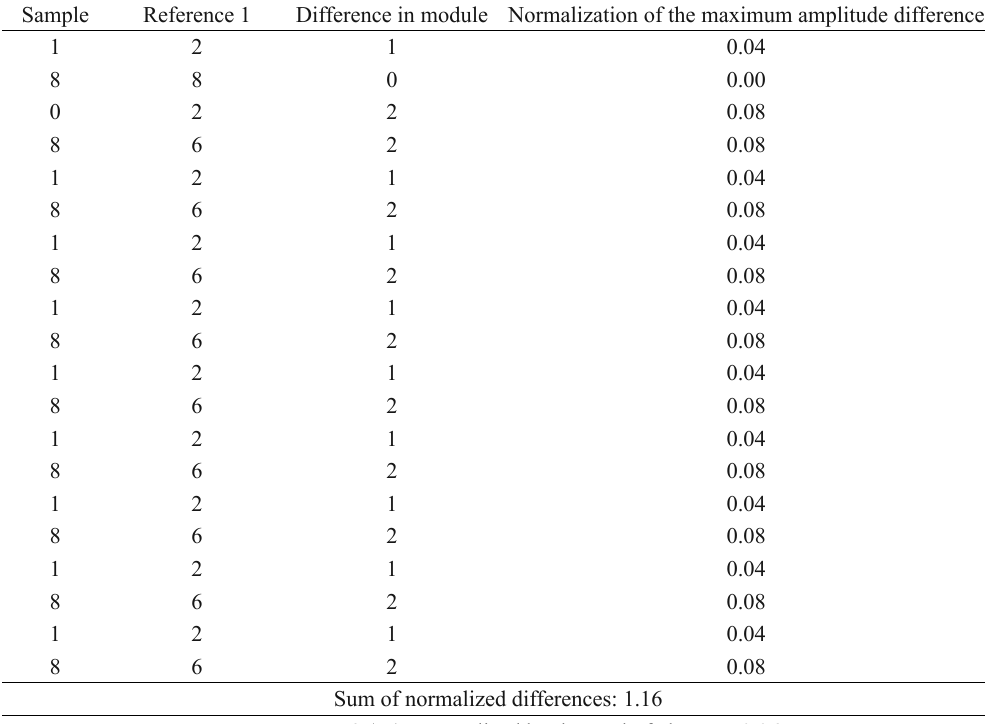
Comparison between the sample and reference 1.